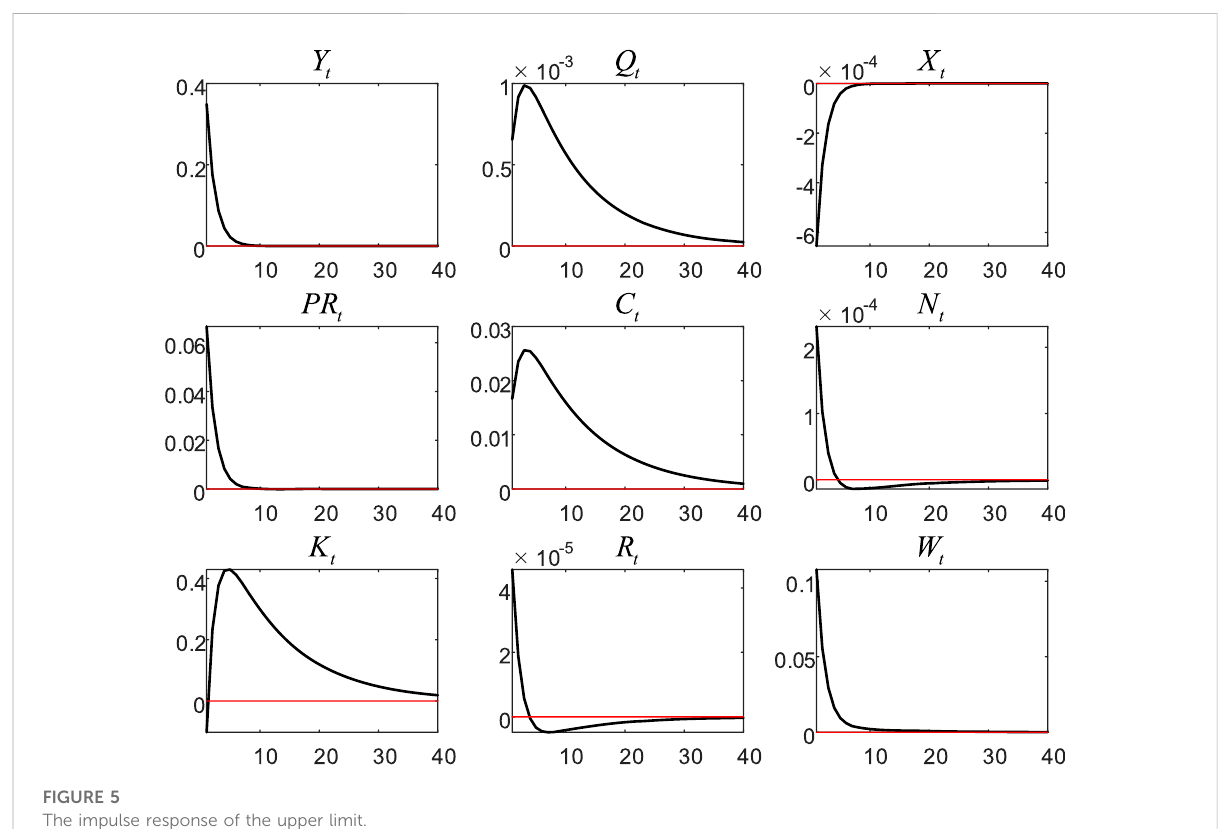
FIGURE 5 The impulse response of the upper